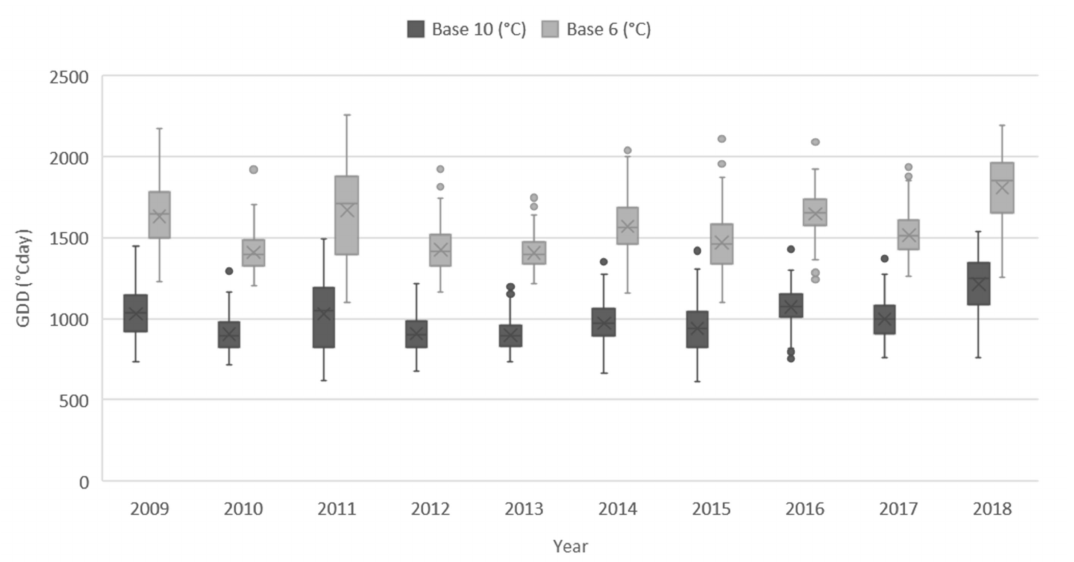
Figure 3. Bow whispers of the growing degrees days (GDD, ◦ C day) cumulative distributions in several locations in European temperate regions (see Section 2.4) within the last 10 studied years for a base temperature of 6 and 10 ◦ C (source: own calculation from the Agri4cast